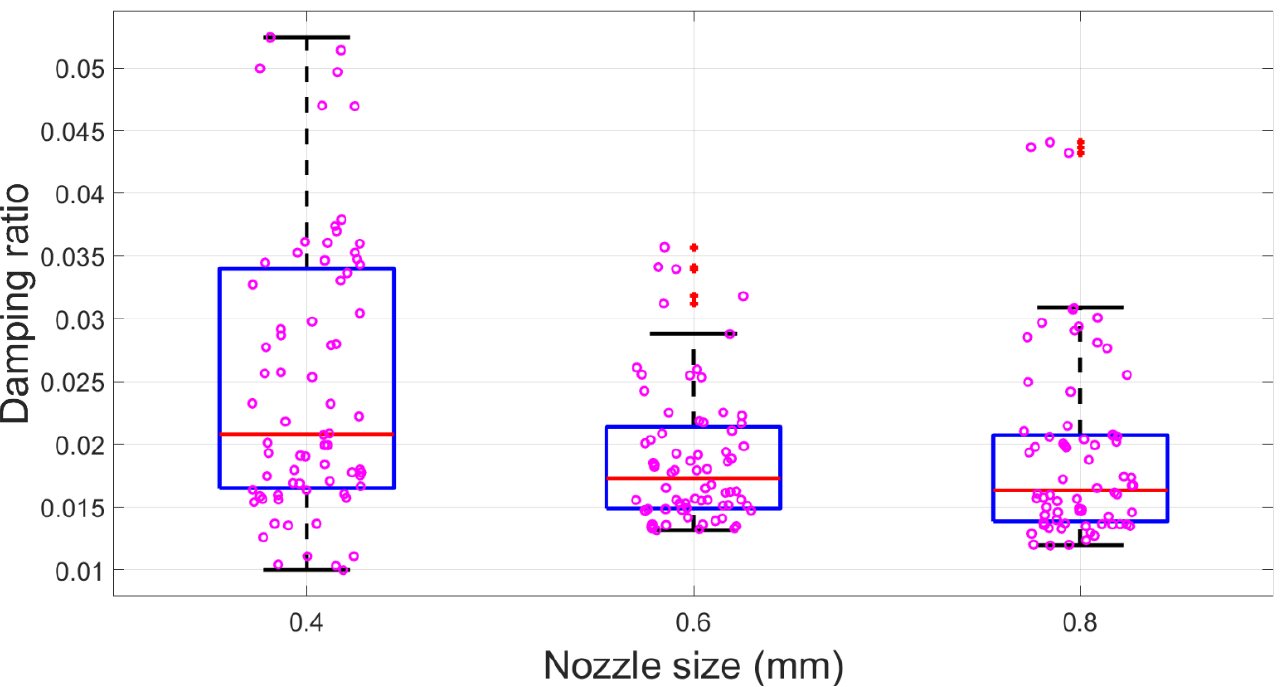
Figure 6. Damping factor box plots for infill density. Red dots are outliers. Violet circles are raw data.